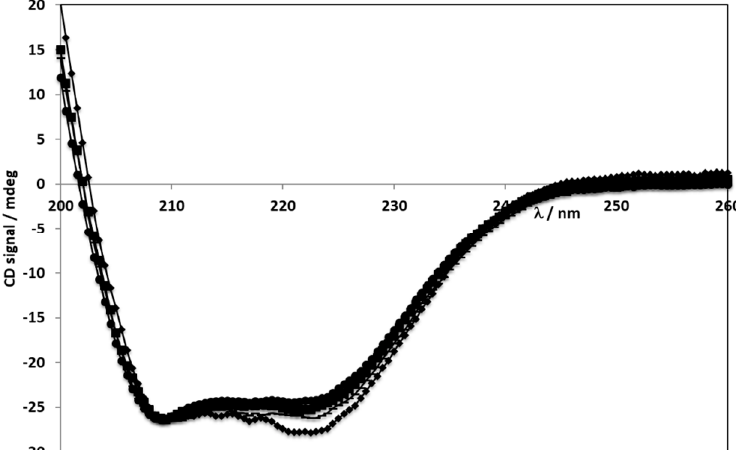
0.4 mg/mL; ■ – ERL conjugated BSA NPs 0.4 mg/mL; ▬ - Destroyed NPs 0.4 mg/mL.